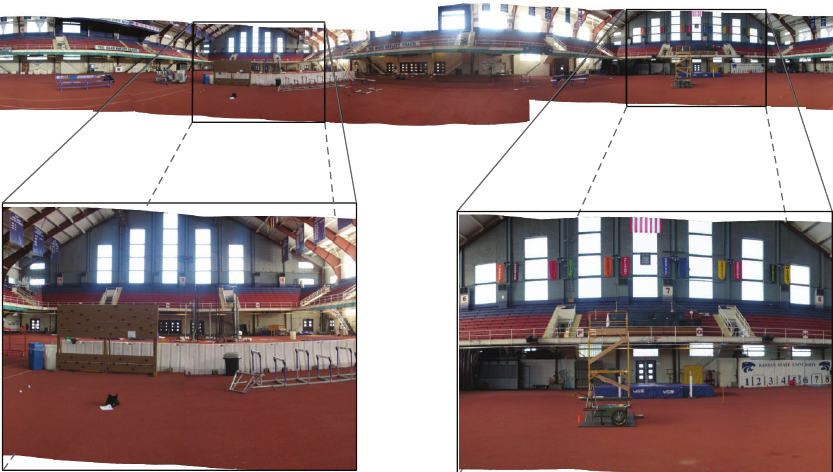
Figure 9: Panoramic view of a field house. One end of the field house is approximately 25 meters from the camera, other is around 125 meters from the